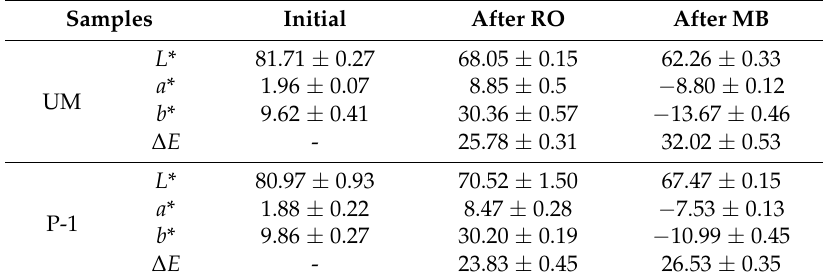
Table 2. Aeshtetical properties of exemplary stained surfaces expressed in chromatic coordinates (CIELAB) and color variations ( ∆ E ) with standard